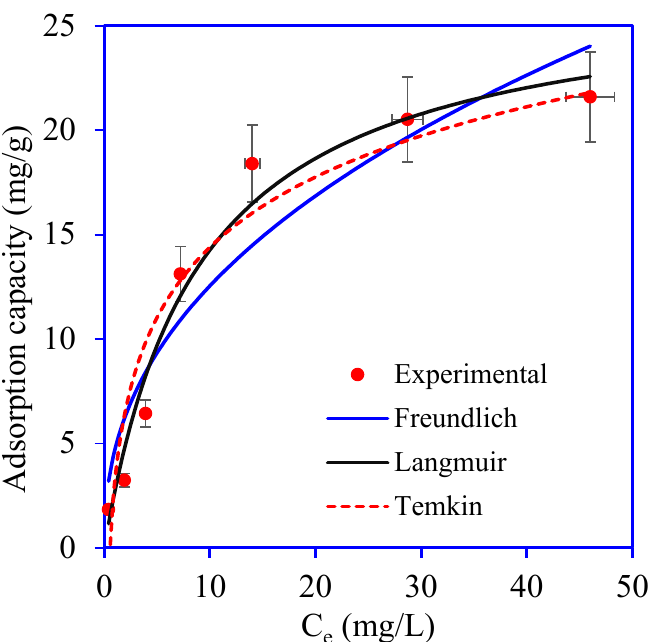
Figure 9. Adsorption isotherm plots for the adsorption of Br − ions onto PANI/GO@GTW from aqueous solution. (solution pH: 3, solution volume: 20 mL, and adsorbent mass: 0.05 g). Data from experimental Br − adsorption trials were examined using the Freundlich, Langmuir, and Temkin isotherm equations to predict the interaction between Br − ions and PANI/GO@GTW. The applied models’ equations are depicted in Table 2. Figure 9 shows the plots for the used isotherm models, and the values of the isotherm parameters are summarized in Table 2. The maximum monolayer adsorption capacity of the PANI/GO@GTW for Br − was observed at about 26.92 mg/g. The values of R 2 (0.972), RMSE (1.29), and χ 2 (1.62) better fit the Langmuir isotherm model compared to the Freundlich (R 2 : 0.901, RMSE: 2.427, and χ 2 : 4.230) and Temkin (R 2 : 0.910, RMSE: 2.306, and χ 2 : 4.587) isotherm models. The isotherm analysis results revealed that the Br − adsorption onto PANI/GO@GTW follows the Langmuir isotherm and monolayer adsorption occurs as each site binds with a single Br − ion [16].